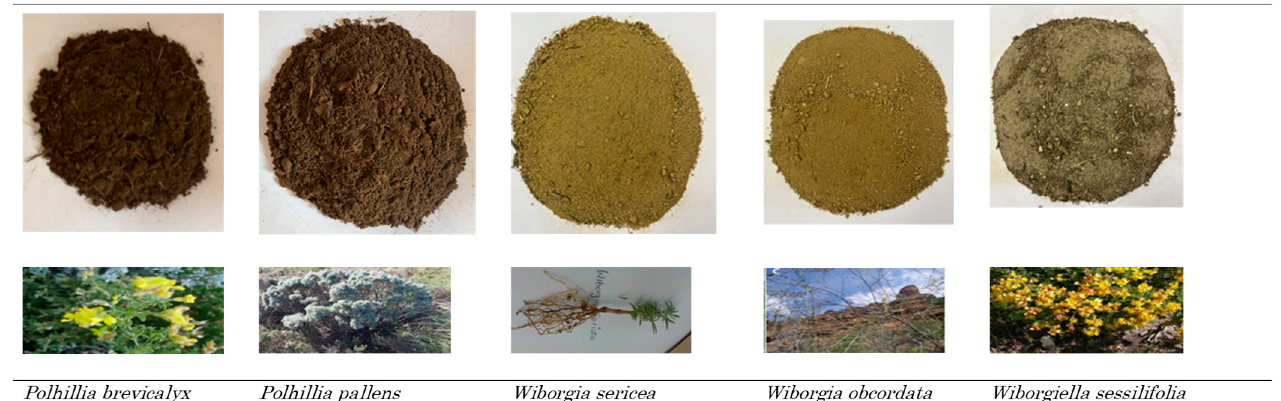
Figure 1. Physical appearance of the soil samples collected from different locations of Cape